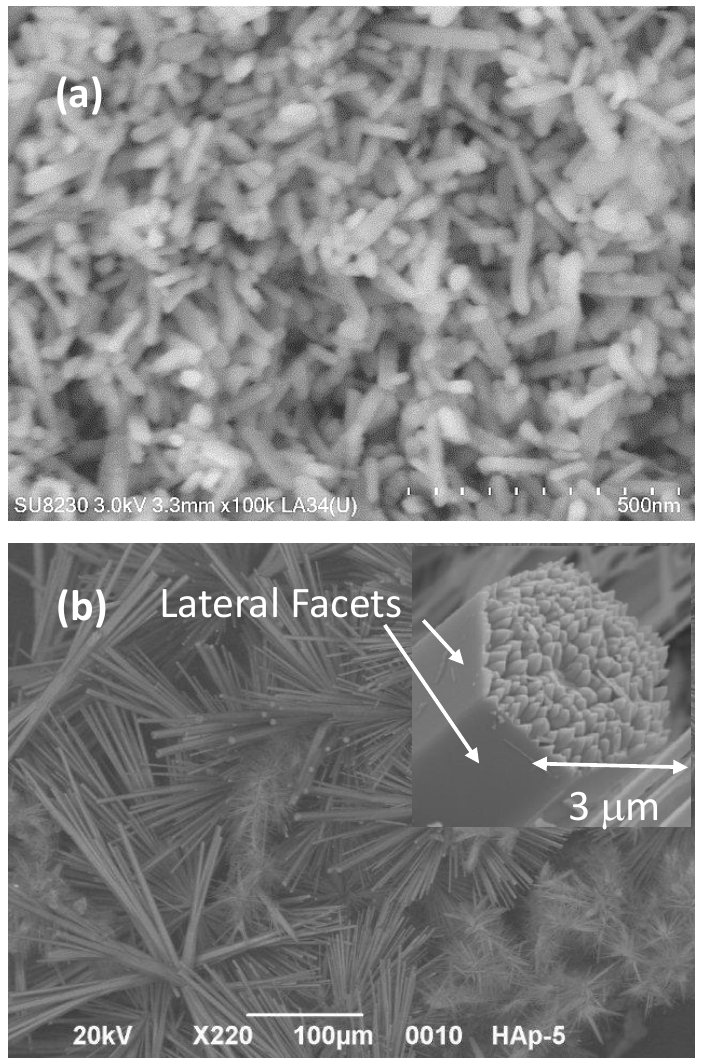
Figure 2. Secondary-electron micrographs obtained by SEM of ( a ) commercial HAp powders and ( b ) HAp nanofibers.